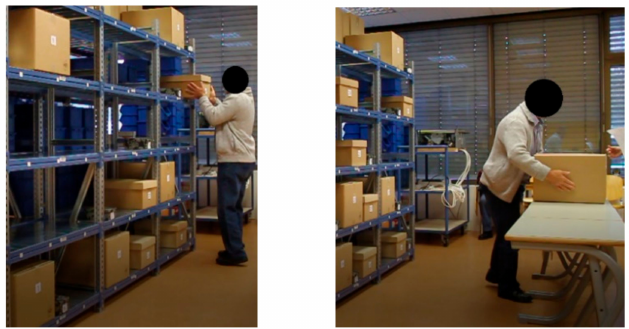
Figure 4. Order picking for the purpose of determining picking times. A sequence of boxes on the picking list was determined randomly and was the same for all participants. The participants did not know how heavy the box they should pick is. After unloading the box on the surface for disposal, the assistant immediately read the new number of the box for picking and removed the box from improvised surface for disposal. A video camera with a rate of 60 frames per second recorded the participants while they were performing the tasks. Later a time study was conducted by measuring picking times directly from the video recordings (Table 3). Table 3. Average picking times from different heights. Average Picking Time at the Height of . . . [s] Type/Mass 13 cm 56 cm 100 cm Large 0.1